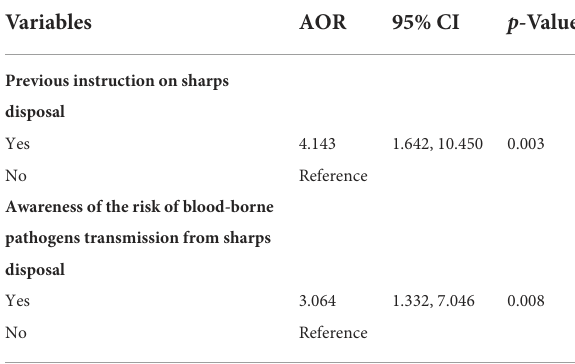
TABLE 4 Multivariate analysis of factors associated with safe disposal of insulin needles ( N =